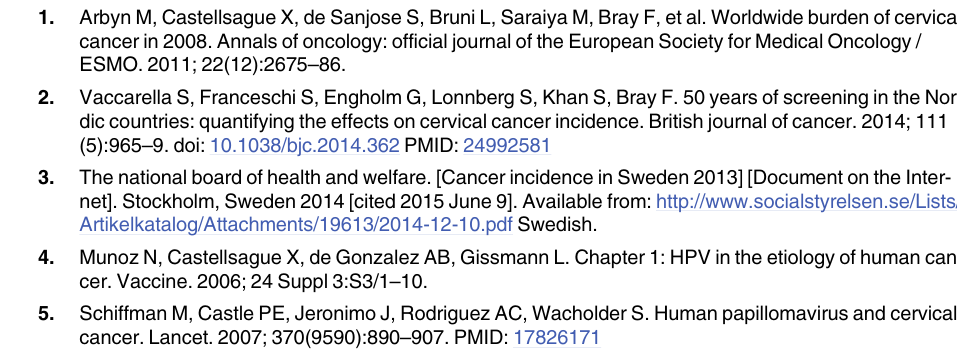
S1 Table. Implementation strategies by county. Information channels used to reach the catch-up group to inform about HPV vaccination and where to receive the vaccine, and vacci- nation settings by county, Sweden 2012 –